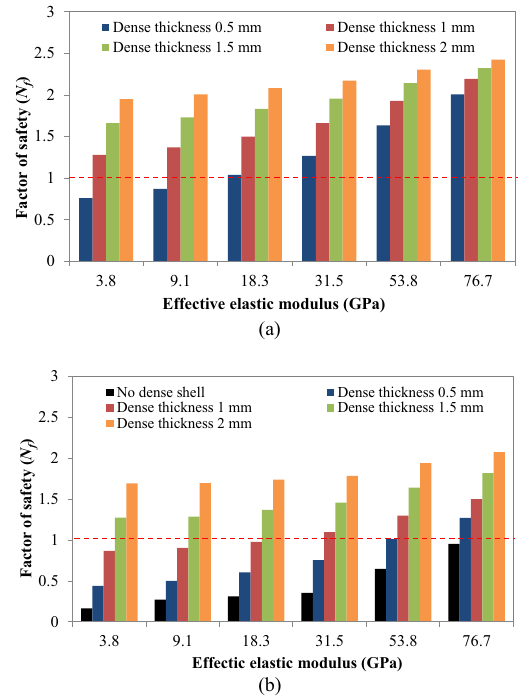
Fig. 7 Utilization of Soderberg approach to calculate the factor of safety; a factor of safety calculated for outer dense shell with different porous stems, b factor of safety calculated for porous section with different porosities